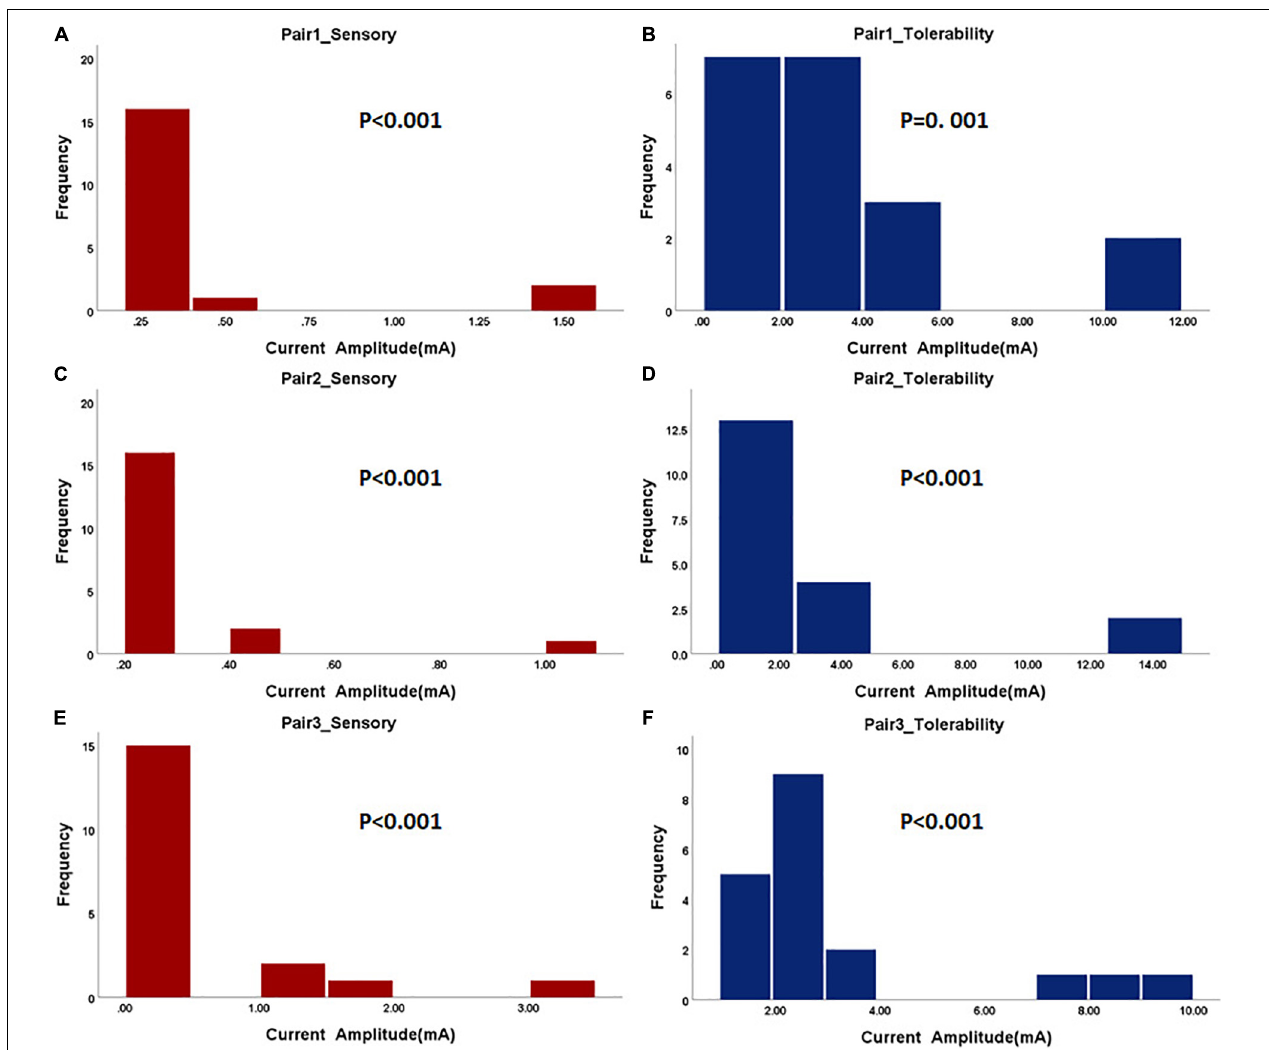
FIGURE 5 | The histogram of sensory and tolerability thresholds of acupuncture electrode pairs. The P -value of the normality test is shown in each figure. P greater than 0.05 was considered as the normal distribution. (A) Sensory threshold of Pair 1. (B) Tolerability threshold of Pair 1. (C) Sensory threshold of Pair 2. (D) Tolerability threshold of Pair 2. (E) Sensory threshold of Pair 3. (F) Tolerability threshold of Pair 3.